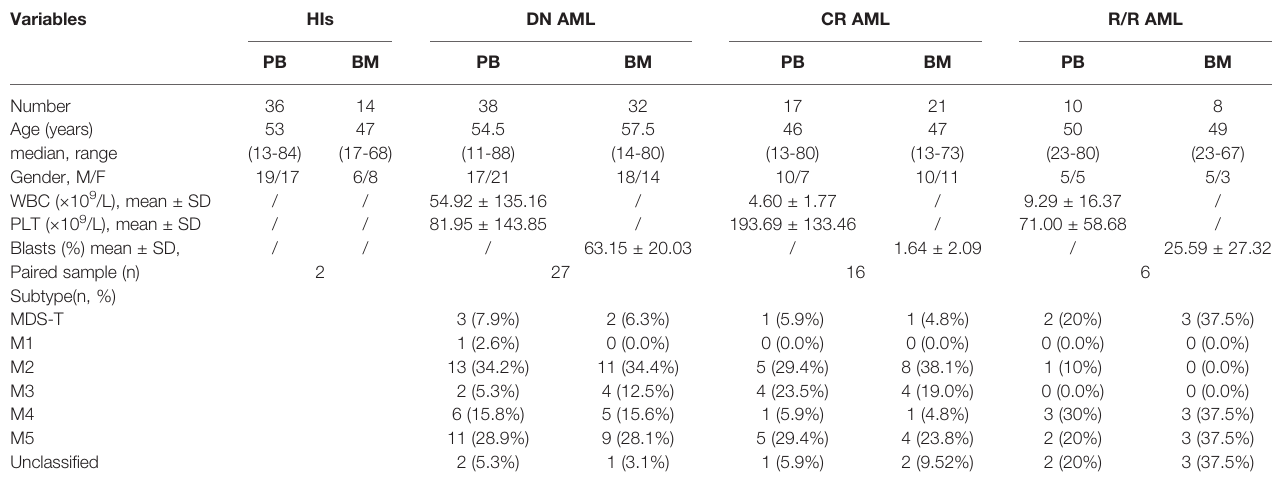
TABLE 1 | Clinical characteristics of HIs and AML